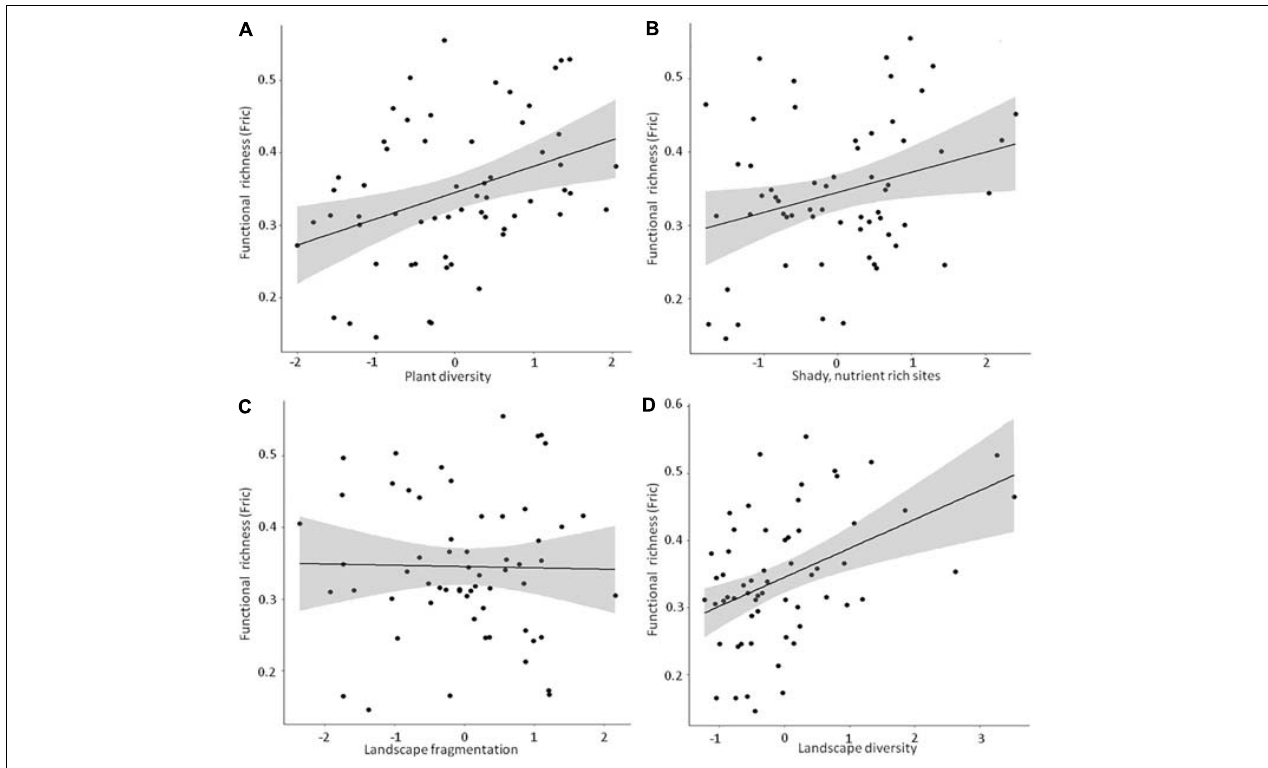
FIGURE 3 | Linear bivariate regressions showing the relationships between moth functional richness (FRic) and (A) Plant diversity, (B) Shady, humid, nutrient rich sites, (C) Landscape fragmentation and (D) Landscape diversity. The detailed results of the linear mixed effects models (shown as black line and shaded area) can be looked up in Supplementary Table 4